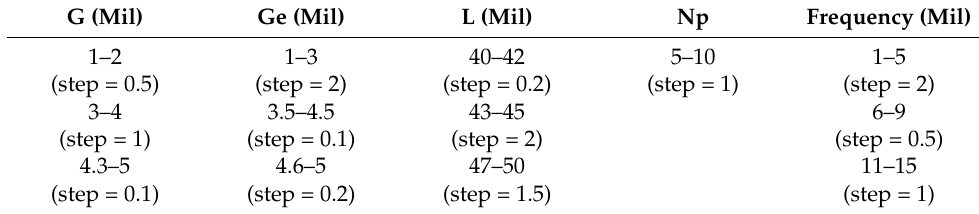
Table 9. Non-uniform sampling of interdigital capacitor.